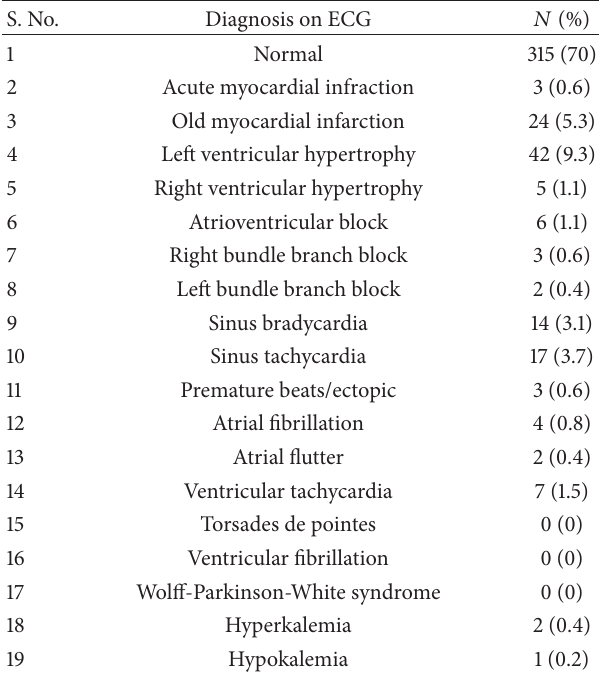
Table 3: Interpretation of handheld